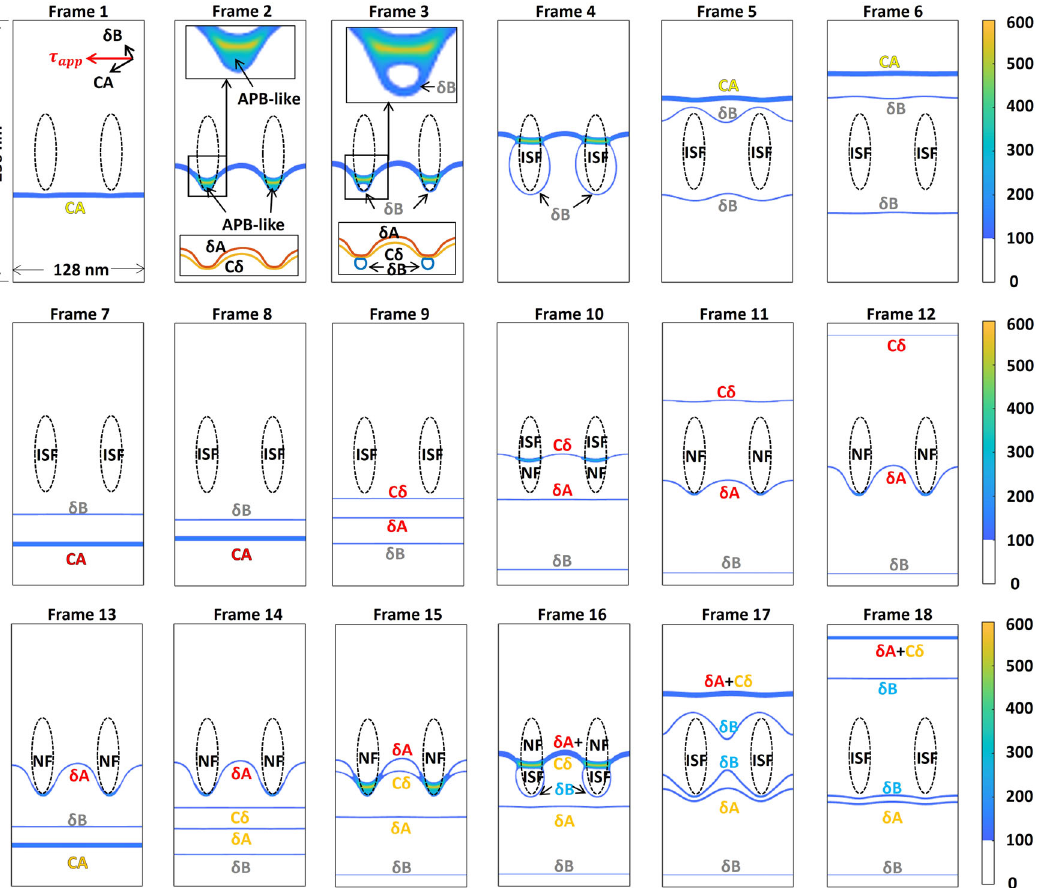
Fig. 2 Interactions between consecutive three CA dislocations with an array of γ " precipitates. The 1st, the 2nd, and the 3rd CA dislocation interacting with γ " precipitates are shown in Frames 1 – 6, Frames 7 – 12 and Frames 13 – 18 respectively. The downward moving δ B partial on the entrance side of the precipitate array at the Frame 6 and Frame 12 have been shifted upward in Frame 7 and Frame 13, respectively, in order to introduce the 2nd and 3rd upcoming CA dislocations from the bottom of the simulation cell. The dislocations on the exit side of the precipitate array at Frame 6 and Frame 12 have been documented in Fig. 3c and cleared in Frame 7 and Frame 13 for better visualization, respectively. The legends have units of mJ m − 2